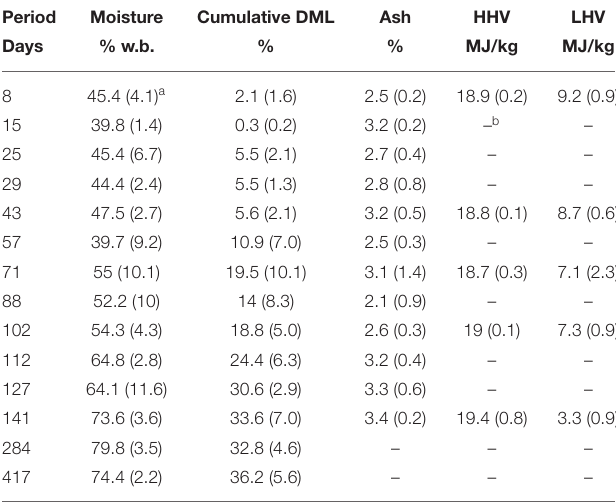
TABLE 4 | Changes (mean and standard deviation) in dry matter loss (DML), moisture, ash, and higher heating value (HHV) and lower heating value (LHV) in a